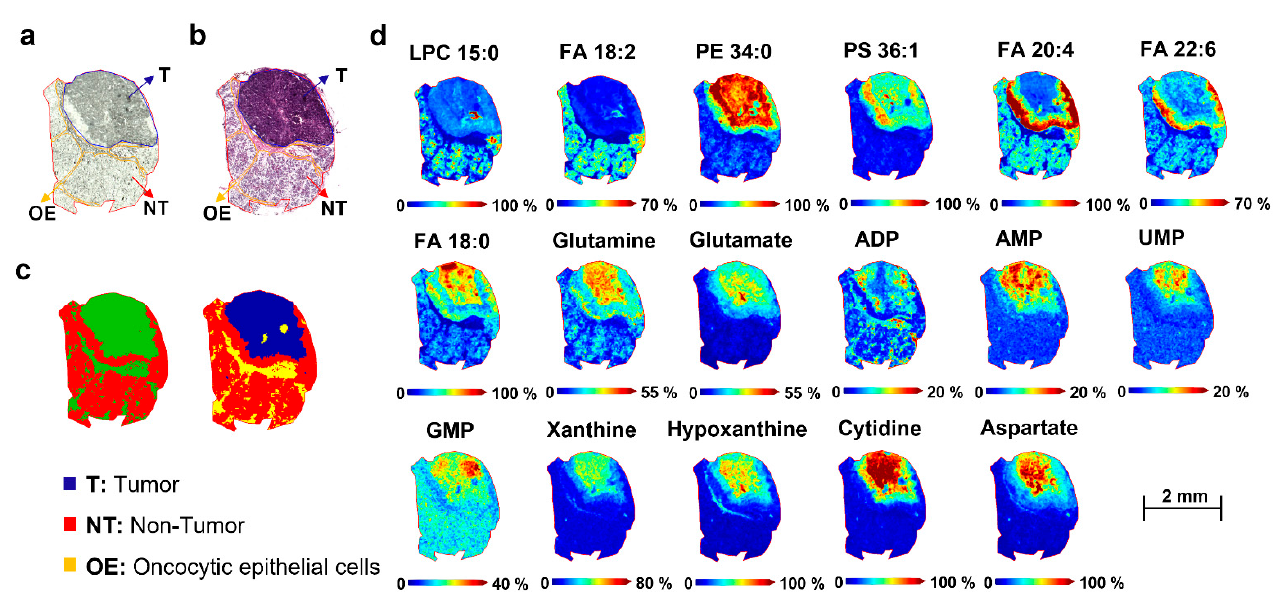
Figure 4. Molecular distribution of non-polar and polar metabolites between tumor and healthy regions of patient-derived parotid sections. ( a ) Optical image and ( b ) Hematoxylin and Eosin (H&E) image of parotid tissue with the pathologist’s annotation of the regions. ( c ) Bisecting the K-means segmentation map generated from the MALDI-negative TOF-MSI dataset. ( d ) MALDI-MS images of relevant lipids and metabolites measured in negative ion mode, comparing the distribution between tumor and healthy regions of the parotid tissue. [LPC 15:0-H] − , m/z 480.32; [FA 18:2-H] − , m/z 279.24; [PE 34:0-H] − , m/z 718.54; [PE 34:0-H] - , m/z 718.54; [PS 36:1-H] − , m/z 524.33; [PS 36:1-H] − , m/z 524.33; [FA 20:4-H] − , m/z 303.22; [FA 22:6-H] - , m/z 327.20; [FA 18:0-H] − , m/z 283.27; [Glutamine-H] - , m/z 145.07; [Glutamate-H] − , m/z 146.05; [ADP-H] - , m/z 426.04; [AMP-H] − , m/z 346.06; [UMP-H] − , m/z 323.06; [GMP-H] − , m/z 362.06; [Xanthine-H] - , m/z 151.02; [Hypoxanthine-H] − , m/z 135.04; [Cytidine- H] − , m/z 242.06; [Aspartate-H] - , m/z 132.04. Detailed parameters for the tentative annotation are re- ported in Tables 2, S2, and S3. Scale bar = 2 mm. Color scale bars are shown as percentages of max- imum intensity and were adjusted for each ion image to show a clear distribution. Data were nor- malized to the total ion count (TIC) of each individual spectrum. Lateral resolution, 50 µm. Abbre- viations: T, tumor region; NT, non-tumor region; OE: oncocytic epithelial cells.